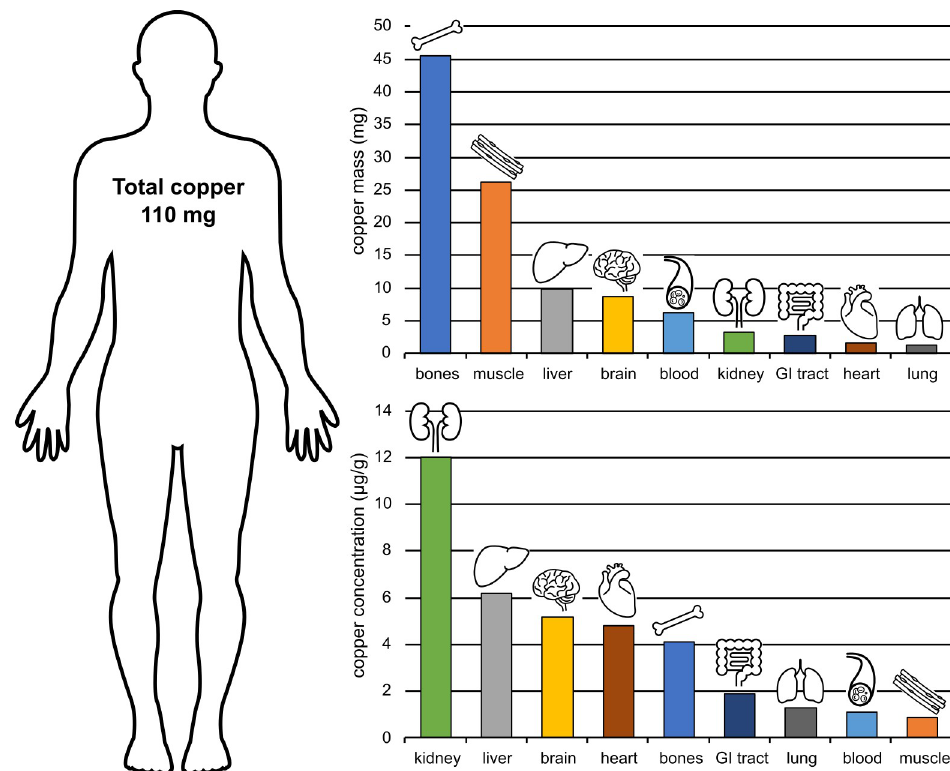
Fig 2. Copper distribution across organs. An average adult human contains approximately 110 mg of copper, the majority of which is ligated in the bones (including bone marrow) and skeletal muscle (top). However, the highest concentration of copper is found in the kidney and liver (bottom), which are the organs chiefly responsible for copper homeostasis. Notice that common infection sites—lung, blood, and the GI tract—can be considered copper poor. GI,